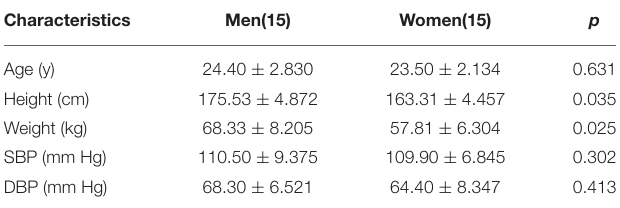
TABLE 1 | Baseline Demographic Characteristics of 30 Participants and p -value between 15 men and 15 women.